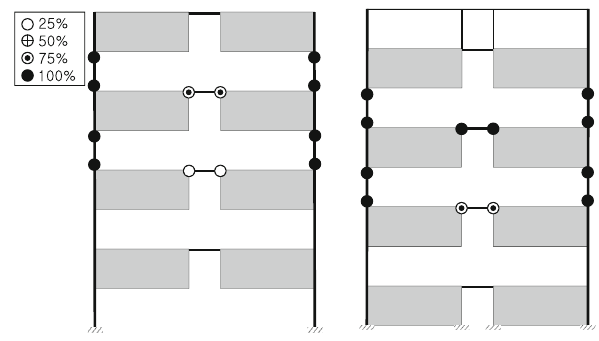
Fig. 11 Plastic hinge formation in the strength-designed structure at the maximum inter-story drift ratio of 2%.